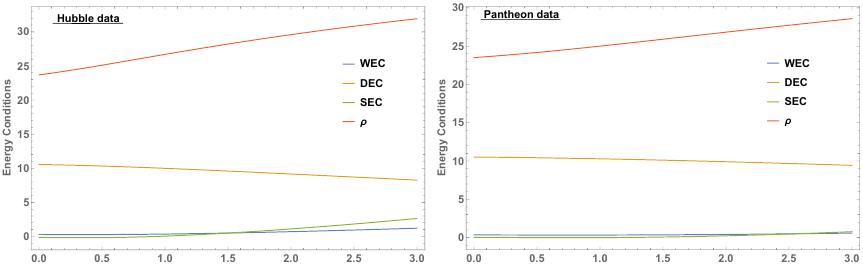
Figure 9. The behavior of energy conditions against the redshift parameter z with the constraint values of the coefficients in (29), for λ = 0.002, γ = 15, β = − 0.5, and f ( Q ) = γ + β log Q .